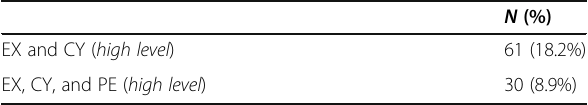
Table 3 Total number of participants suffering from a high level of MBI-SS EX and CY ( high level ) 61 (18.2%) EX, CY, and PE ( high level ) 30